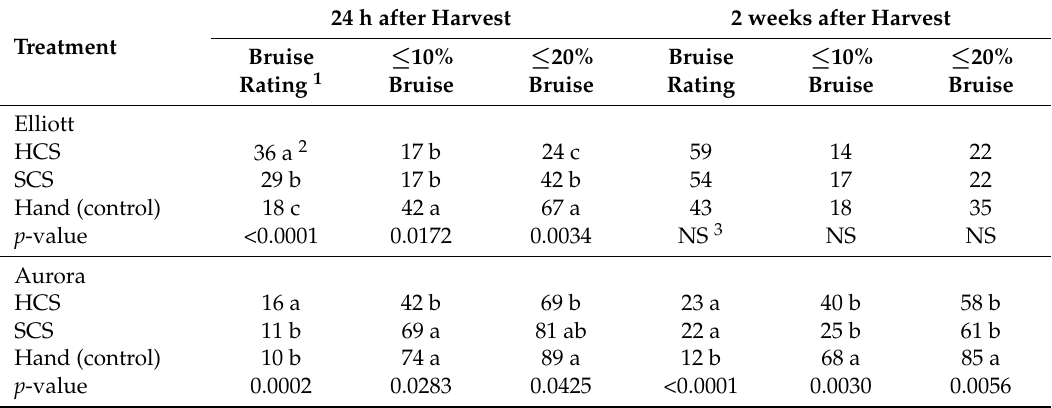
Table 5. Incidence of bruising in ‘Elliott’ and ‘Aurora’ blueberries 24 h and 2 weeks after machine harvesting using a modified over-the-row harvester prototype with Orbirotor ® picking heads and experimental hard and soft catch surfaces (HCS and SCS, respectively) in Washington. Machine harvested berries were compared to hand-harvested (control) fruit in Washington in 2017. 24 h after Harvest 2 weeks after Treatment